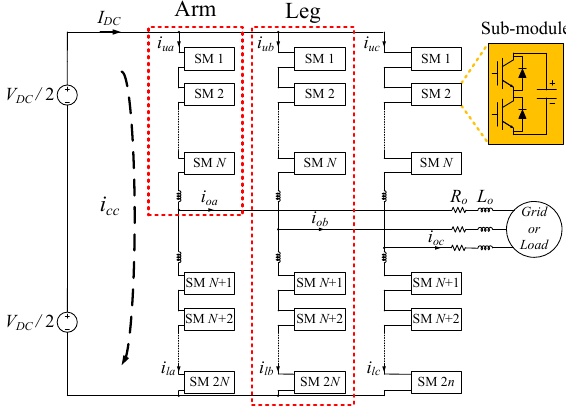
Figure 3. Configuration of the three-phase modular multilevel converter (MMC).